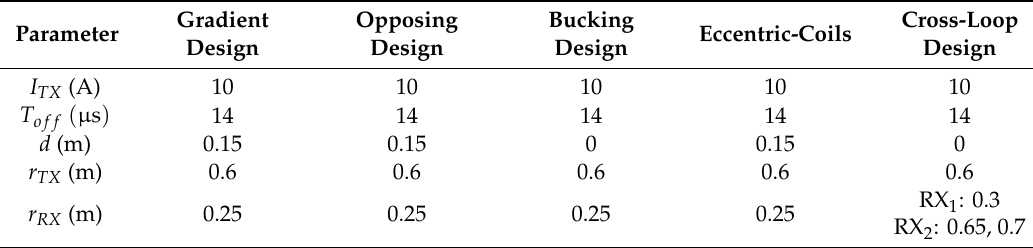
Table 5. Parameters of the five weak coupling coil